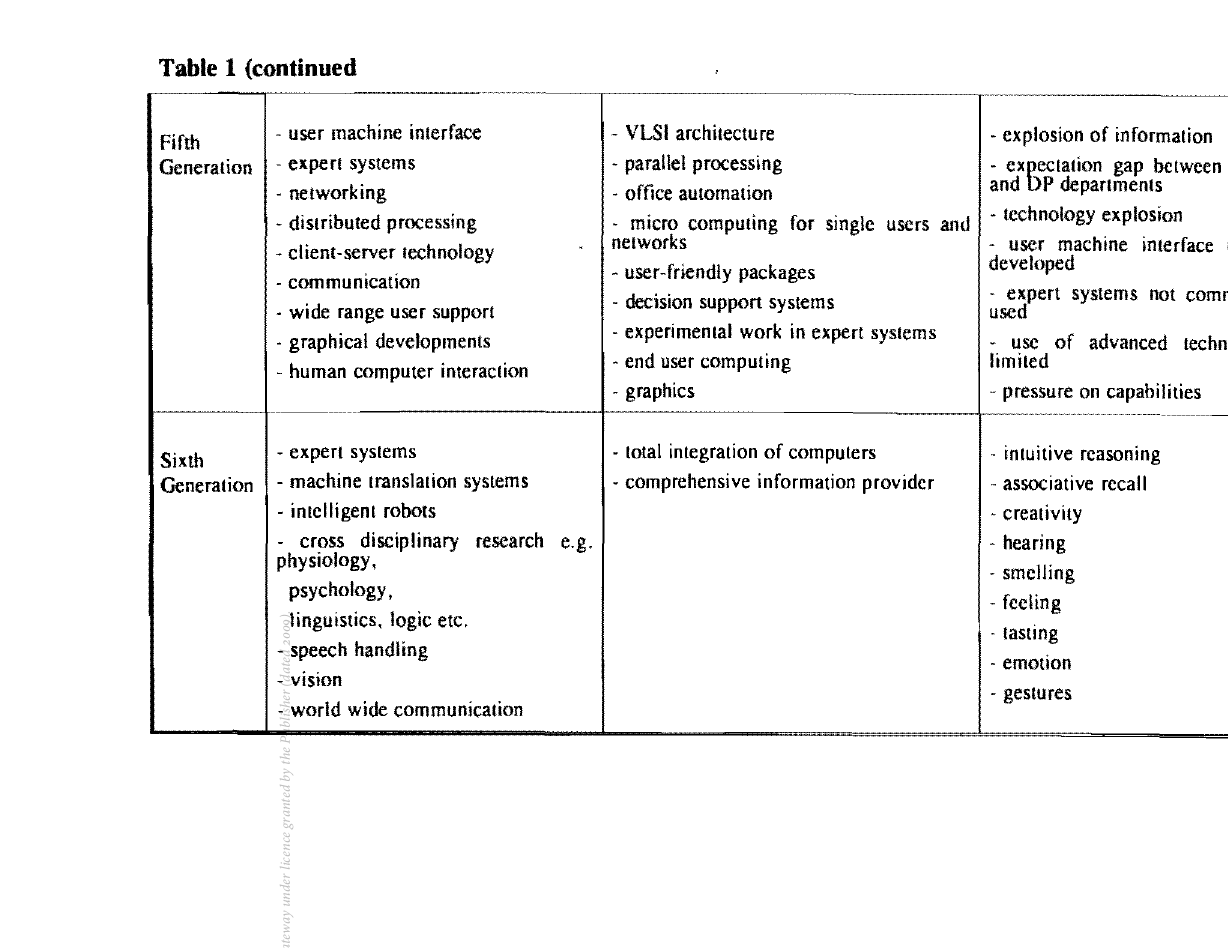
- user machine interface Fifth - expert Generation